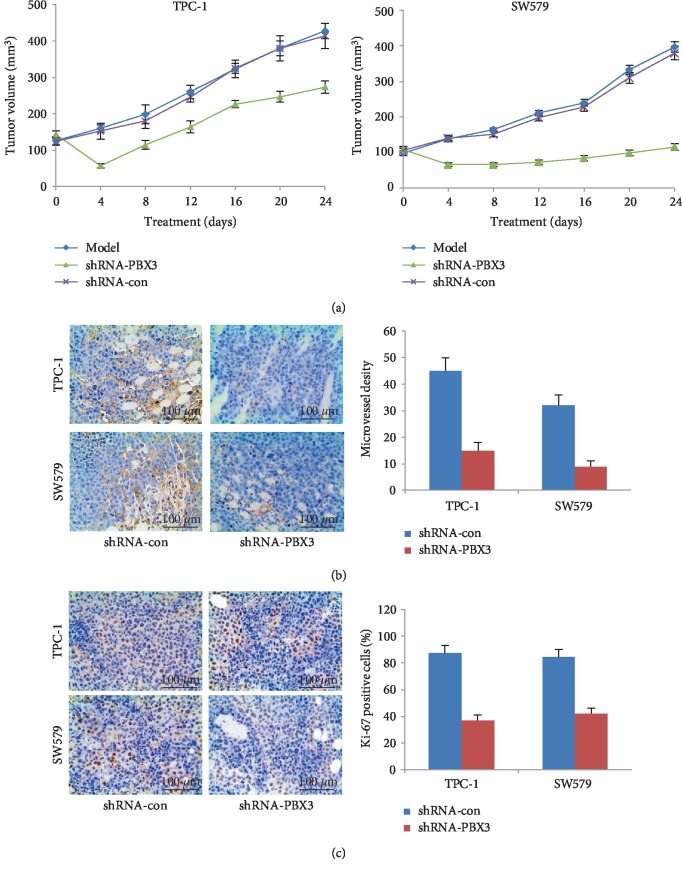
Knockdown of PBX3 suppressed PTC cell growth in nude mice. (a) HCT-8 cells stably infected with HPIP shRNA or control shRNA or parental HCT-8 cells were injected into nude mice, Tumor sizes were measured at the indicated times. Immunoblot analysis of (b) CD31, and (c) Ki-67 in tumor tissues. All values are shown as mean ± SD (n = 5). ∗P0.05 versus corresponding control shRNA.